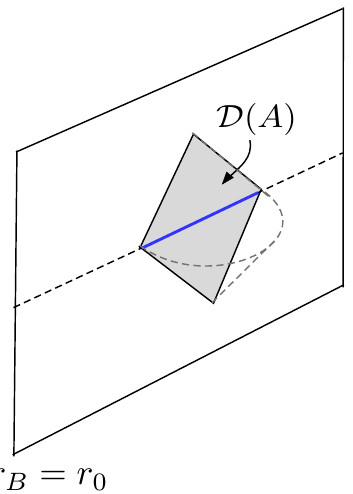
Figure 3 . The two-point function can be written in terms of the symplectic (cid:13)ux integrated over the domain of dependence ( A ) (the shaded region) of A (blue line) on a radial slice of an auxiliary D AdS spacetime, close to the asymptotic